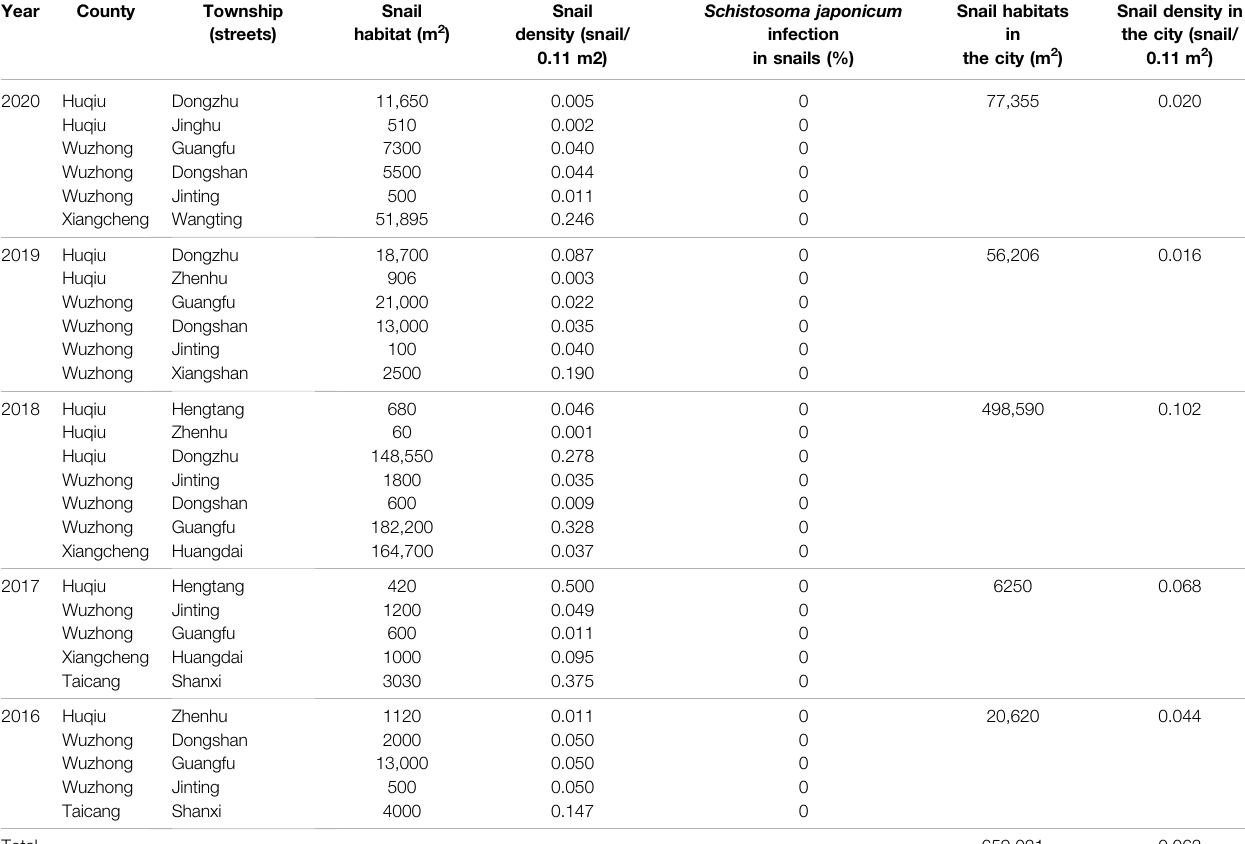
TABLE 2 | Distribution of Oncomelania hupensis in Suzhou City from 2016 to